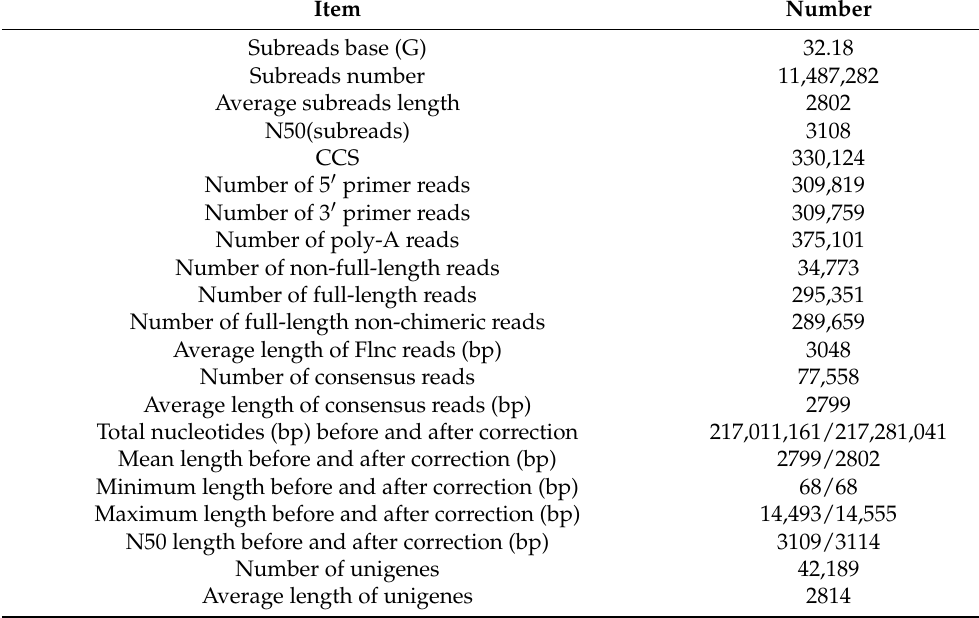
Table 1. Summary of reads from third generation long-read